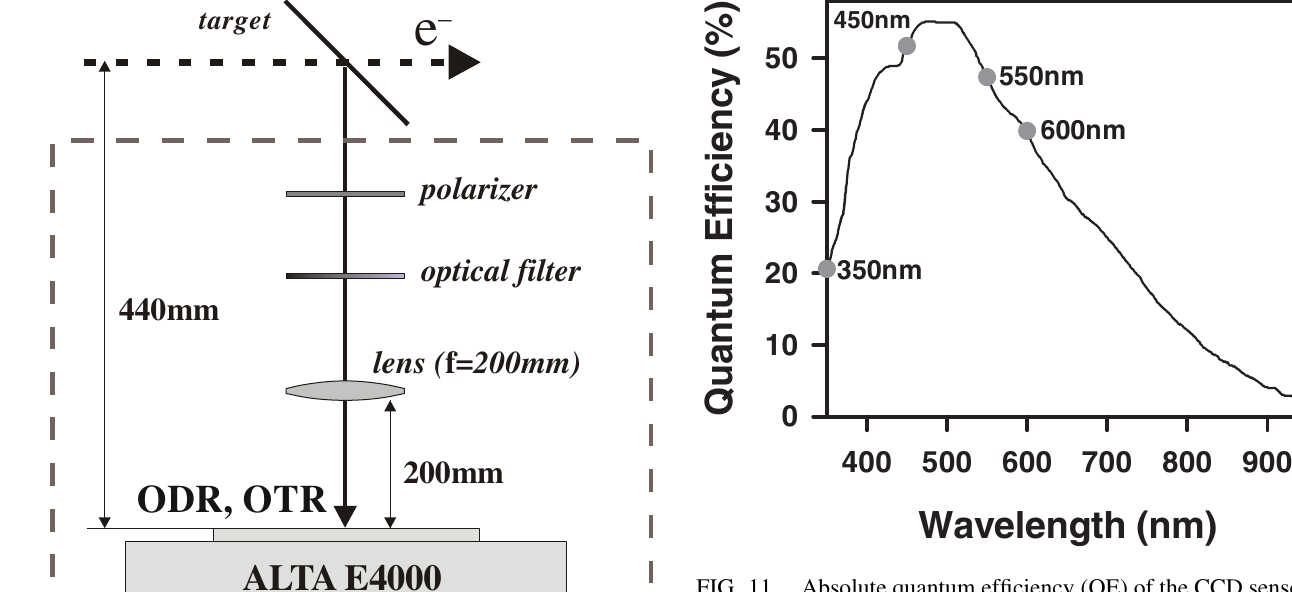
FIG. 11. Absolute quantum efficiency (QE) of the CCD sensor as a function of the detecting radiation wavelength. Gray points indicate the QE of the CCD sensor for central wavelengths of the FIG. 10. Detector module. optical filters used in the